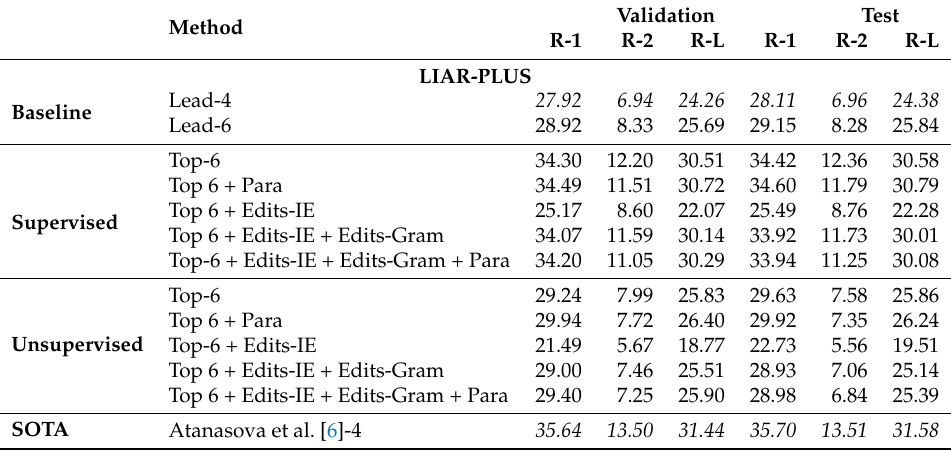
Table A3. ROUGE-1/2/L F1 scores (see Section 5.1) for the edited justifications, higher results are better. Results in italics are those reported in the corresponding related work. Ablations are provided for the method as well – input selected sentences of Top-6, iterative-editing (Edits-IE), grammatical corrections (Edits-Gram), paraphrasing